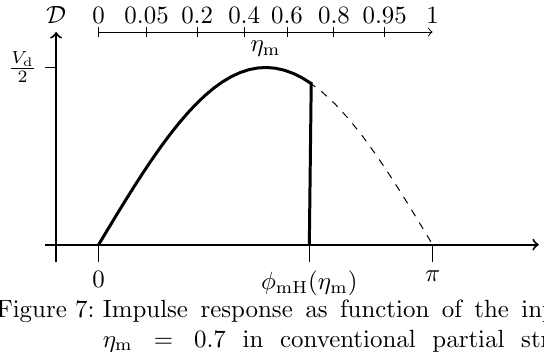
Figure 7: Impulse response as function of the input, η m = 0 . 7 in conventional partial stroke operation.